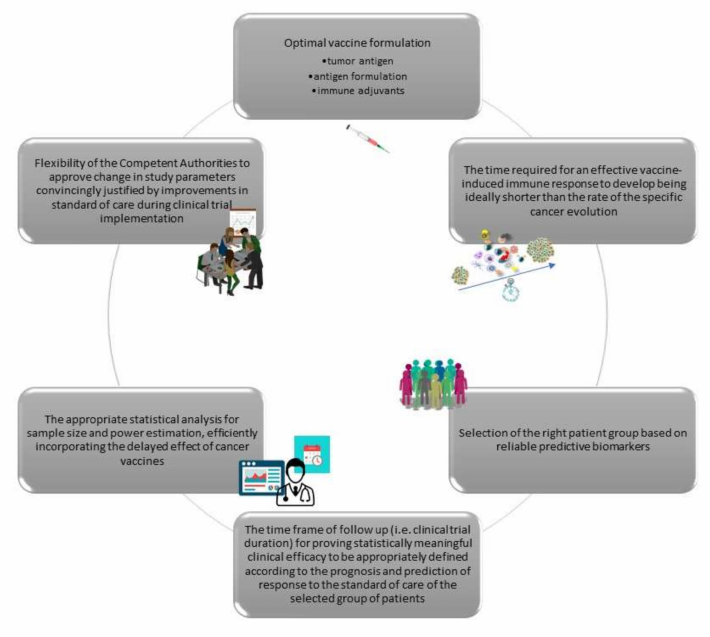
Figure 2. Clinical cancer trials utilizing cancer vaccines report vaccine-induced immunity in the context of different clinical outcomes. Based on our knowledge of why therapeutic cancer vaccines have